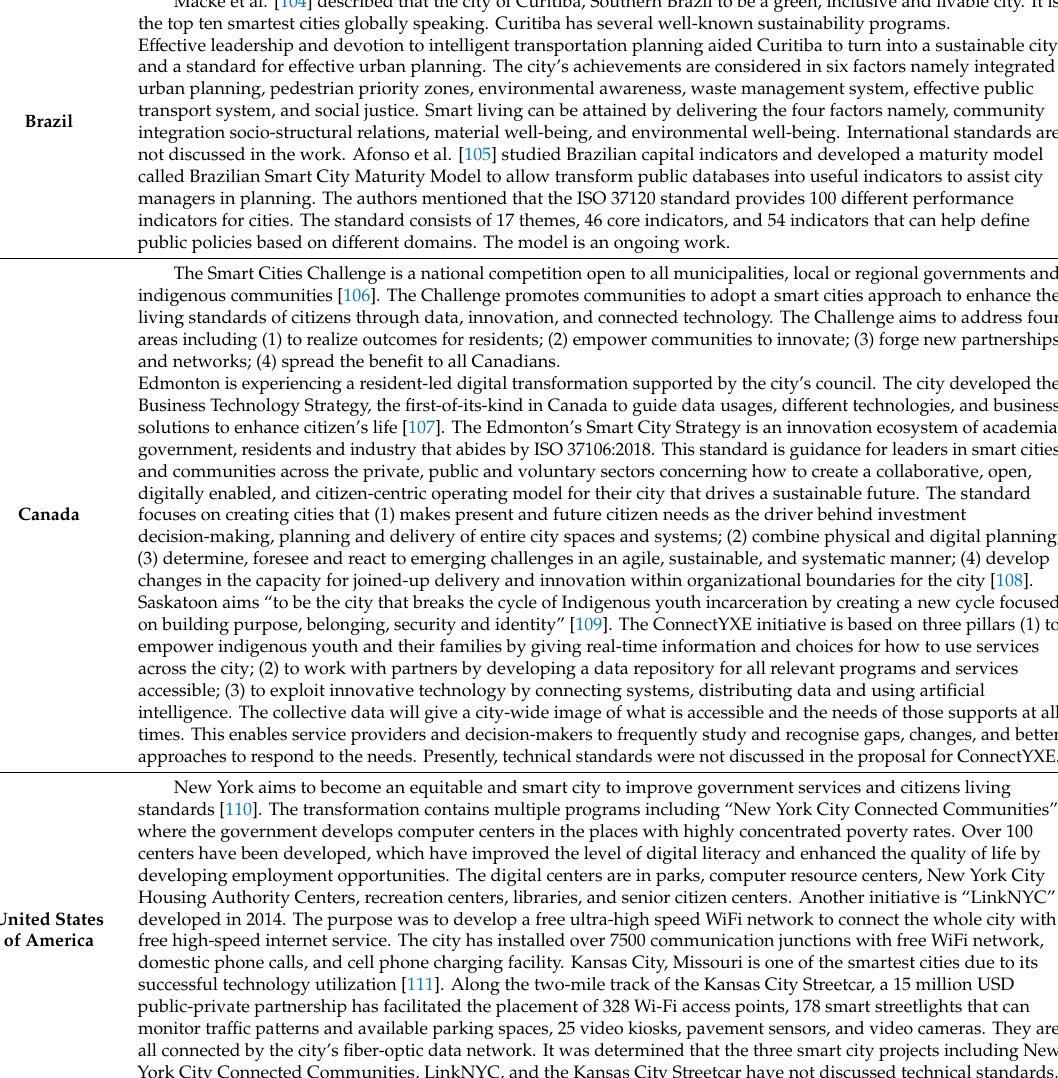
Table 9. Smart cities pilot projects in North America and South America Country